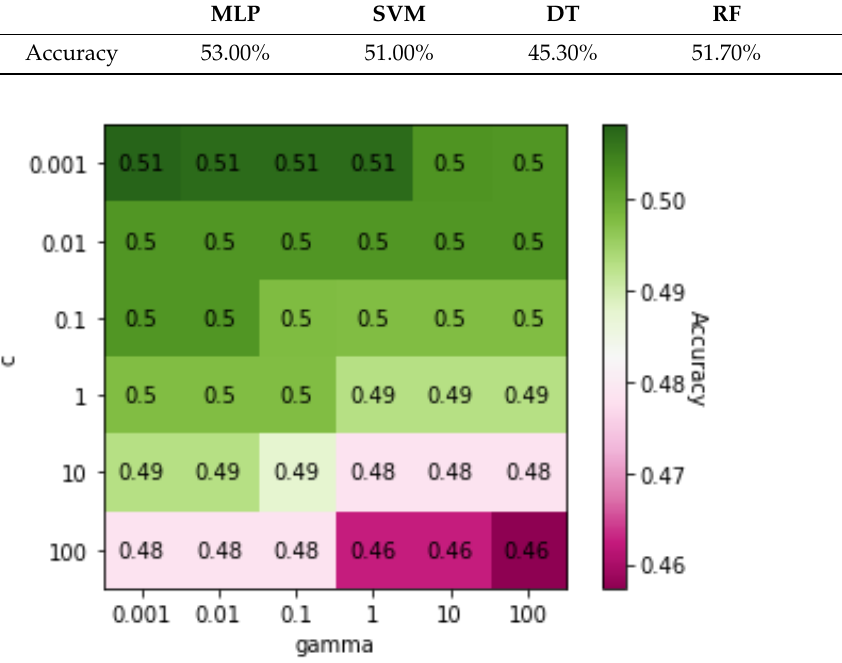
Figure 7. Heatmap of values of SVM parameters C and γ on Dataset 06 when classification was based on occupation.